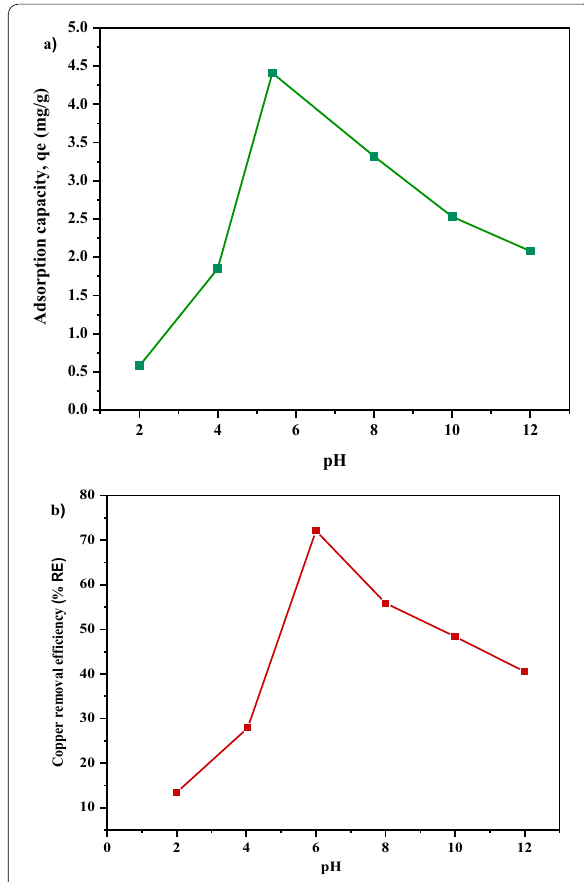
Fig. 13 a Adsorption capacity; b copper removal efficiency under various pH of MNA-7 h (metal solution: 200 mL; initial concentration: 50 mg/L; temperature: 25 °C; adsorbent MNA dosage: 0.05